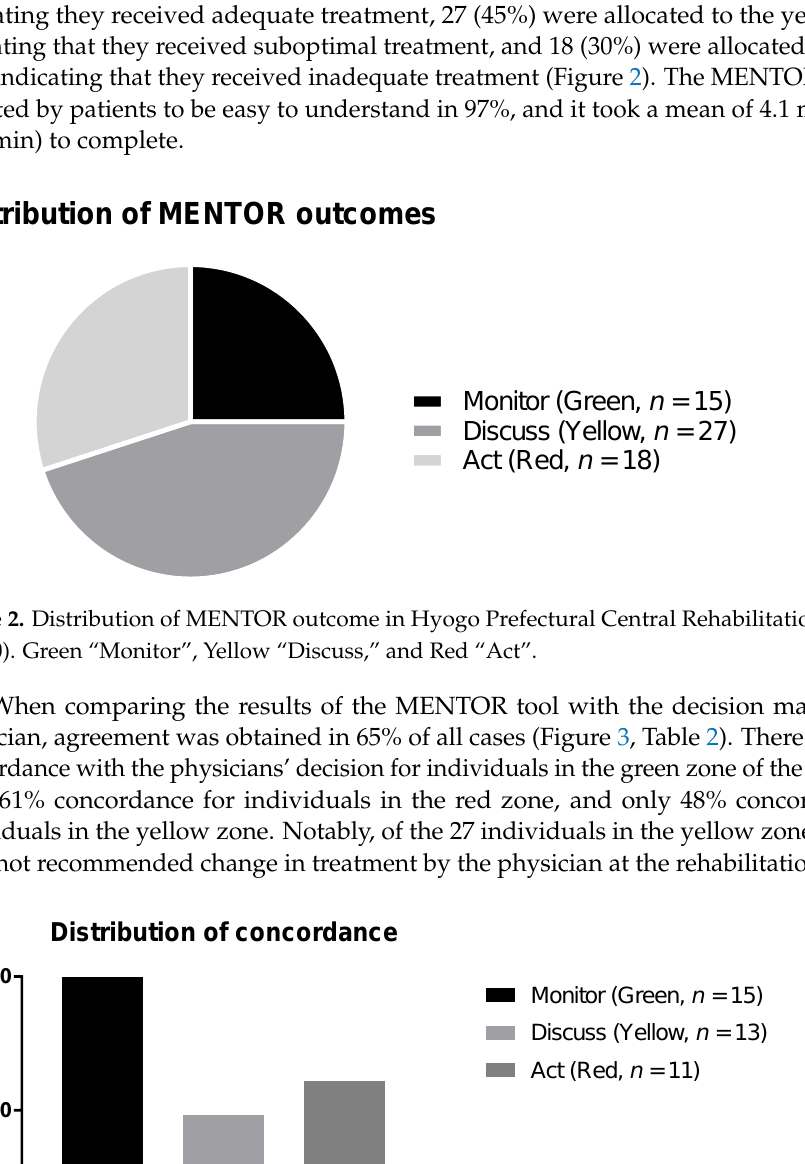
Table 2. MENTOR results and agreement with physician.